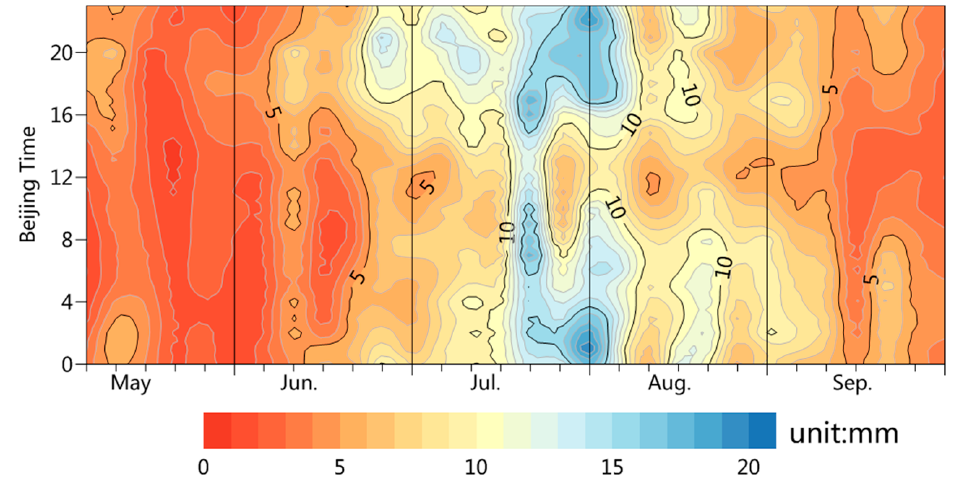
Figure 6. The pentad variations of the hourly mean precipitation in the Haihe River basin, 2007–2017. The seasonal precipitation of each tributary is featured with a single peak in the diurnal variation. July has the highest precipitation of the rainy season, followed by August, and May witnesses the lowest precipitation. The tributaries share a similar diurnal variation pattern (Figure 7). During the first pentad of May and second pentad of July, the diurnal precipitation of each branch reaches a single peak, with most rainfall coming in the afternoon or at night. From the third pentad of July till the fourth pentad of August (major flood season), the peak of the hourly mean precipitation occurs before dawn in the Luanhe River, the Beisan River, the Nanyun River, the Zhangwei River, the Tuma River and the lower reach of the Haihe River. As for the Beisan River, the Yongding River, the Daqing River and the Ziya River in the mountainous areas, the peak appears in the afternoon or at night. The lower reach of the Haihe River, the Nanyun River and the Tuma River also witness high rainfalls for one hour in the afternoon.